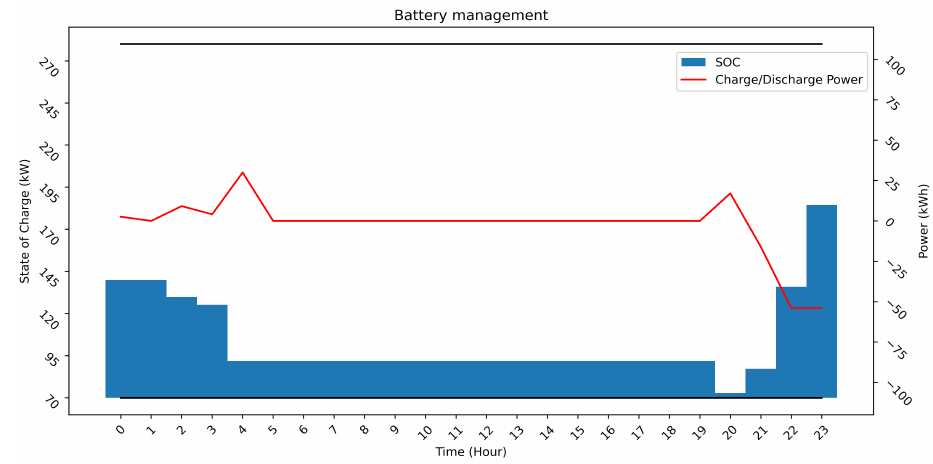
Figure 14. Management of BESS based on MIP approach to case 2. Table 8. The on–off status of the units each time period of the day using the GA.